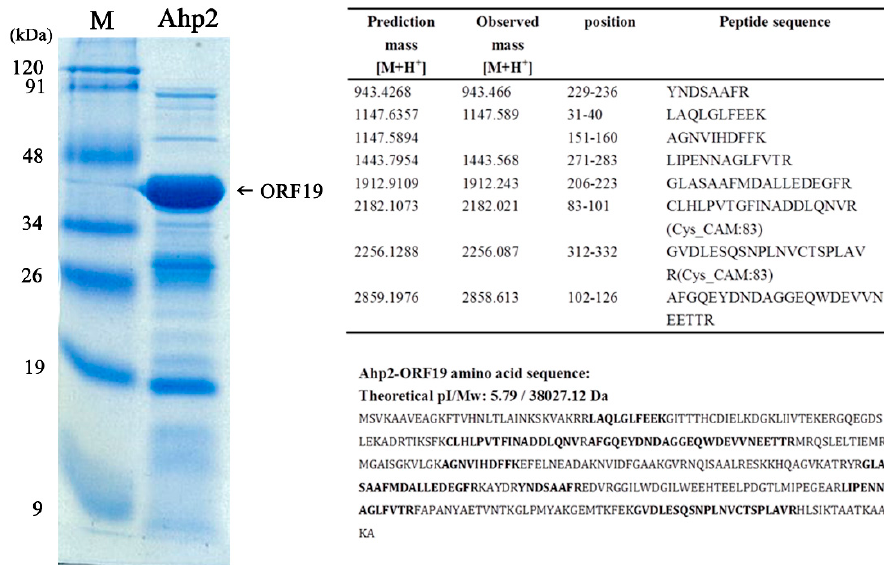
Figure 5. Ahp2 virion proteins. Phage particles (5 × 1011 PFU) were boiled in sample buffer (20 µ L) and subjected to SDS-polyacrylamide gel electrophoresis (8–16% gradient). The arrow indicates ORF19, which has been identified by peptide mass fingerprinting as the major coat protein of Ahp2. The peptide fingerprints matched the deduced sequence of ORF19 shown in the right panel. Cysteine residues in the protein were converted to carbamidomethyl-cysteine (Cys_CAM) with iodoacetamide. Lane M, pre-stained middle range protein marker. Boldfaced sequence: peptide identified by MALDI-TOF.